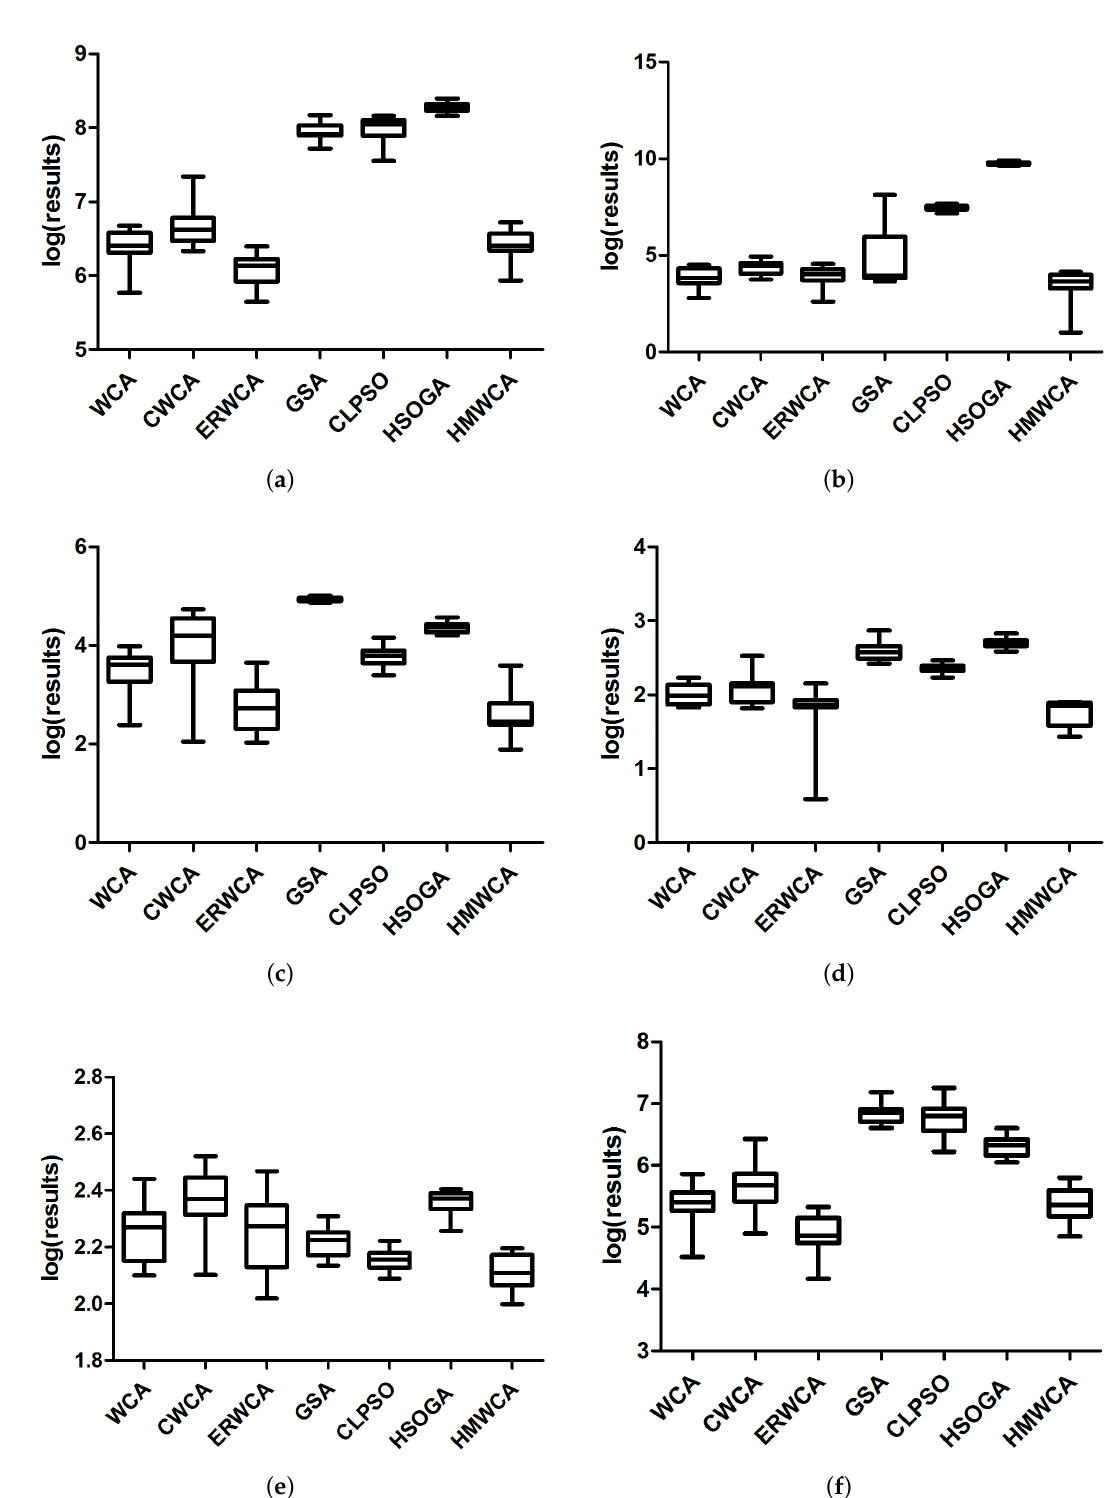
Figure 3. The comparisons of the results of the seven studied algorithms for the functions ( a ) f 1